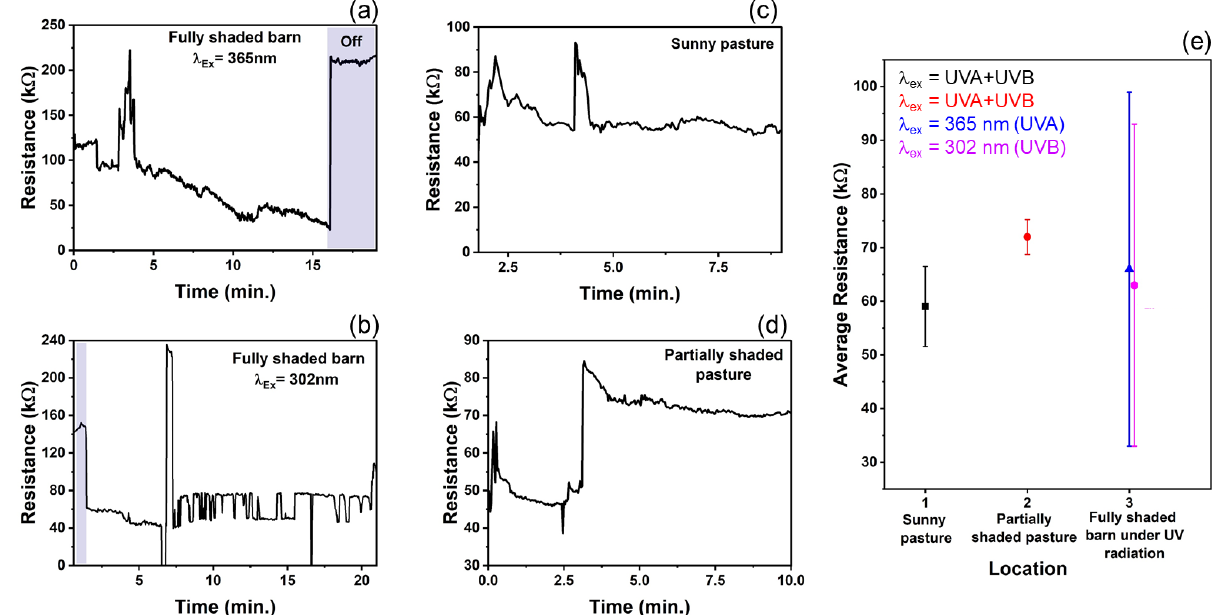
Figure 7. Resistance response of T-ZnO from collar placed on ruminant in various environments. ( a , b ) In dark barn under UV B and UV B irradiation ( c ) Full-sun pasture with UV light intensity ranged 2.2 – 3.0 mW/cm 2 , and ( d ) Partially shaded pasture with UV light intensity ranged 1.4 – 3.0 mW/cm 2 . ( e ) The average resistance of T-ZnO film from collar placed on ruminant, with standard error, in each respective environment.